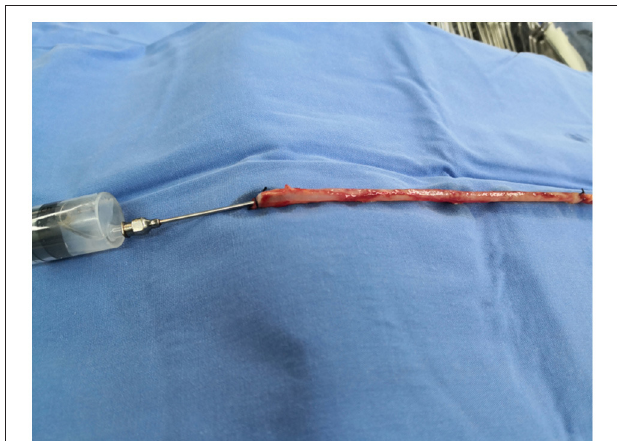
FIGURE 2 | Conventional technology.